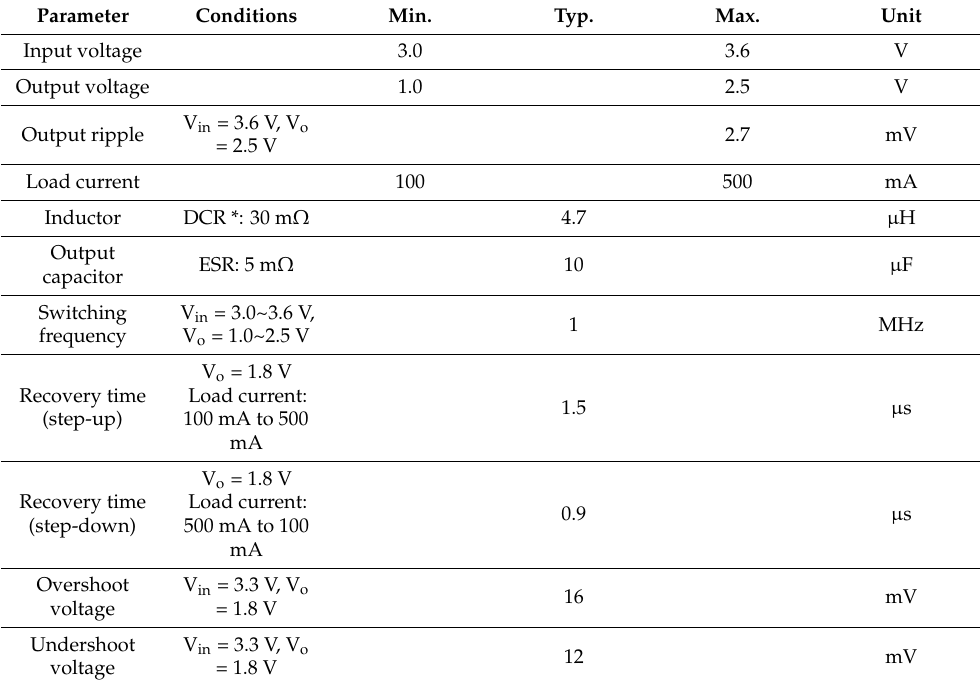
Table 2. Performance